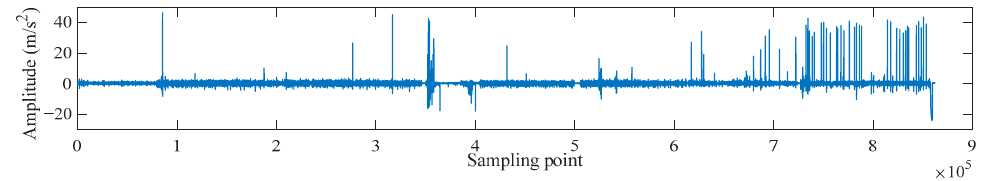
Figure 10. Check valve sampling signal.